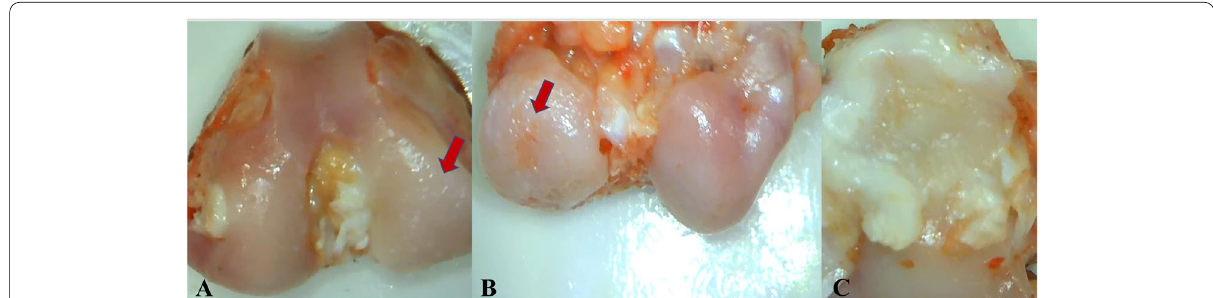
Fig. 4 Gross pathological macrographs after 16‑weeks from surgery where the load bearing area of femoral condyles appears eburnated, irregularities and pitting can be detected (red arrow, 4 A ). Note full‑thickness ulcer in the weight bearing area of the medial femoral condyle with irregularities and pitting (red arrow, 4 B ). The rim of the medial tibial plateau shows a whitish osteophytes and erosions (4 C ). Images were acquired using a 10_objective lens under bright field. Images were then digitally